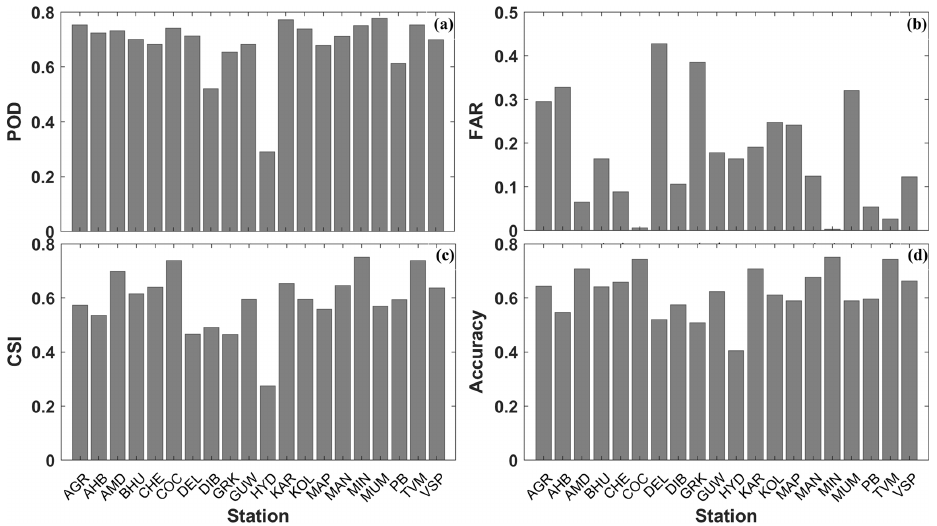
Figure 4. Statistical indices (a) POD, (b) FAR, (c) CSI and (d) ACC in the comparison between the INSAT-3D CAPE with radiosonde CAPE for 20 stations in India.